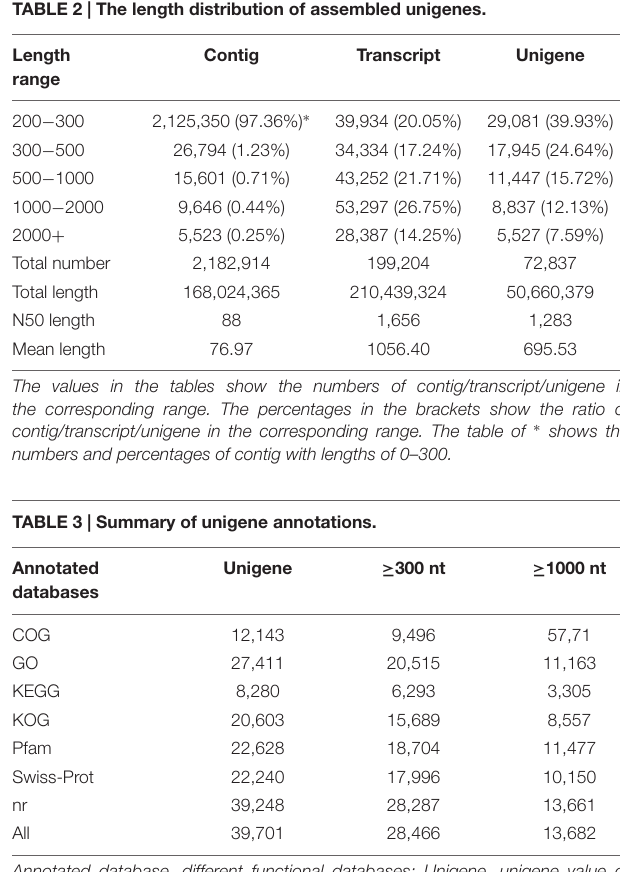
TABLE 2 | The length distribution of assembled unigenes.